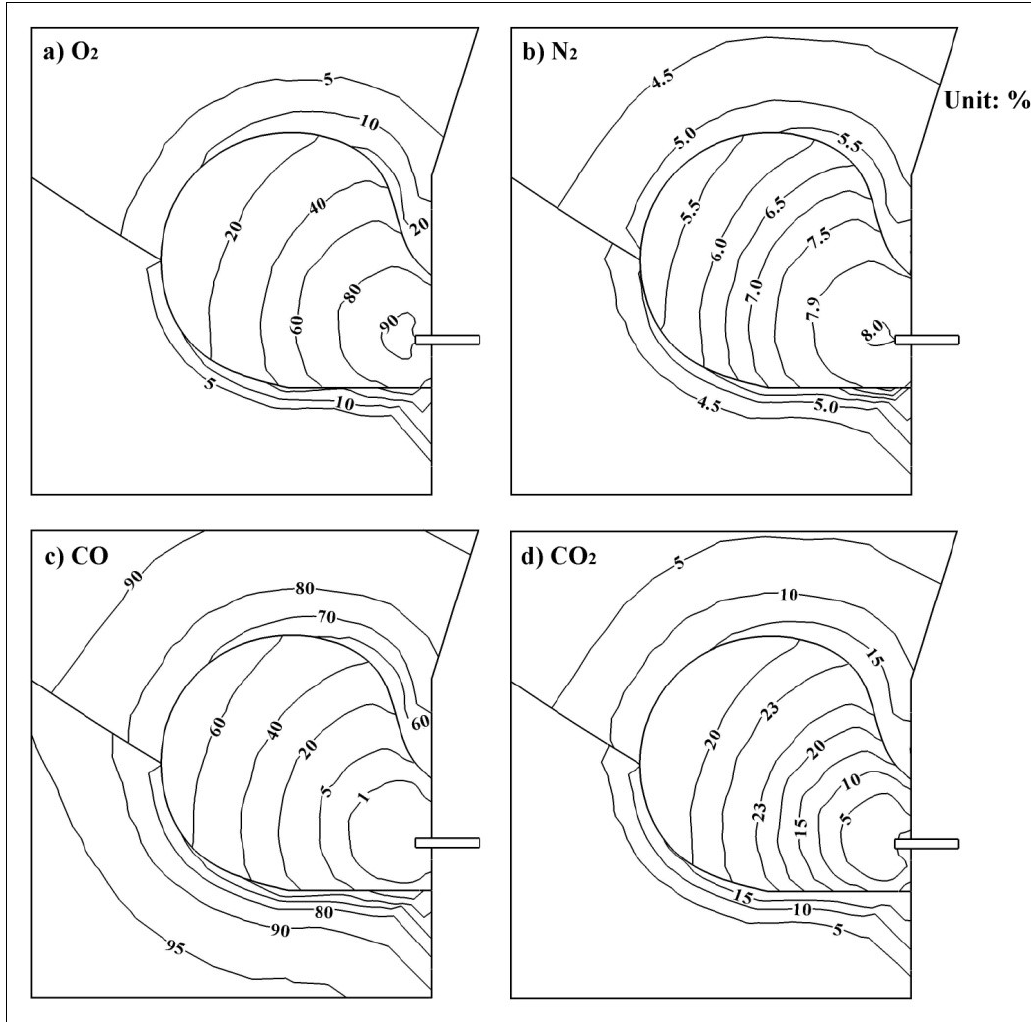
Figure 7: Volume fraction distributions of gas species around raceway for additional N 2 injection with a concentration of